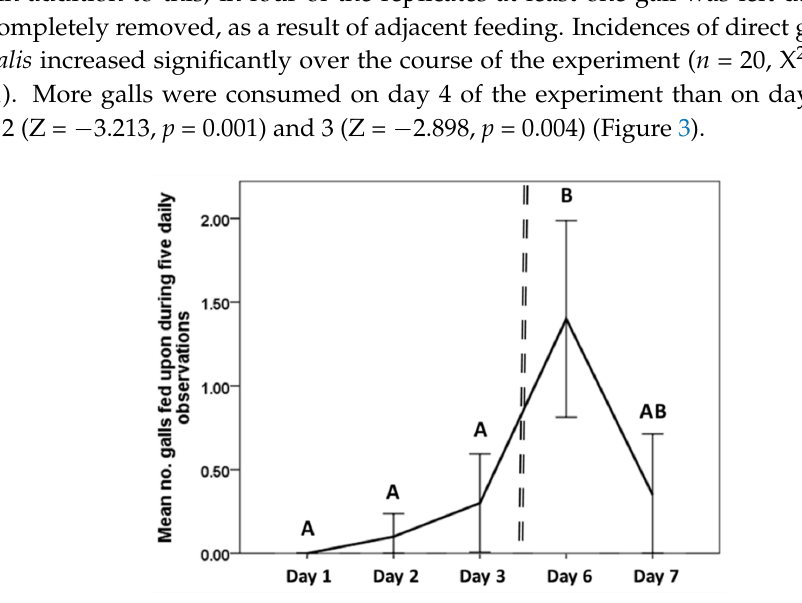
Figure 3. The number of new galls fed upon by individual 3rd/4th instar N. conspurcatalis larvae ( n = 20) over 5 observation days. The line represents the mean number of galls fed upon over each sample period. The dashed vertical line represents a break in data collection between days 3 and 6. Error bars represent standard error. Different letters indicate significant differences.